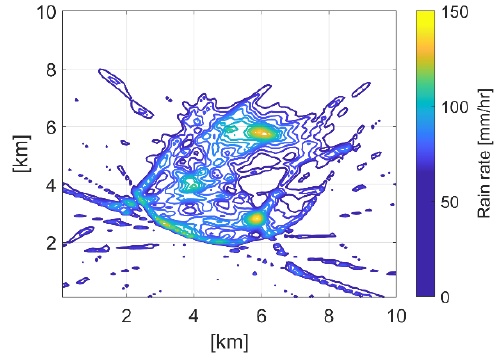
Figure 9. Reconstruction after partial displacement of the rain field.